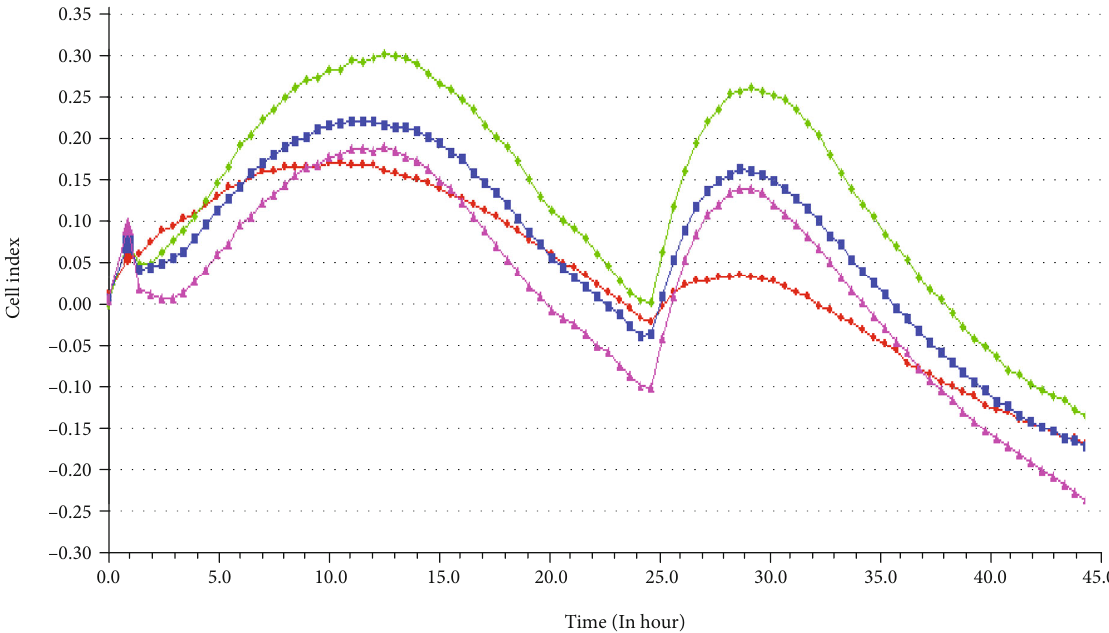
Figure 6: Real-time monitoring results of RTCA analysis system. The time from inoculation of E-Plate 16-hole plate to the start of synchronization; without serum culture, RTCA monitored the e ff ects of miR-145-5p and MSLN on the proliferation of COLO320 cells in colorectal cancer. The control group, MSLN group, and mir-145-5p group were compared with the mir-145-5p+MSLN group, and there was statistical signi fi cance between the two groups ð P < 0 : 01 Þ